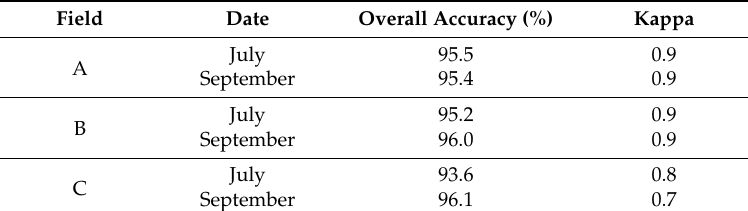
Table 5. Classification statistics (Overall accuracy and Kappa index) obtained in confusion matrix at every location and